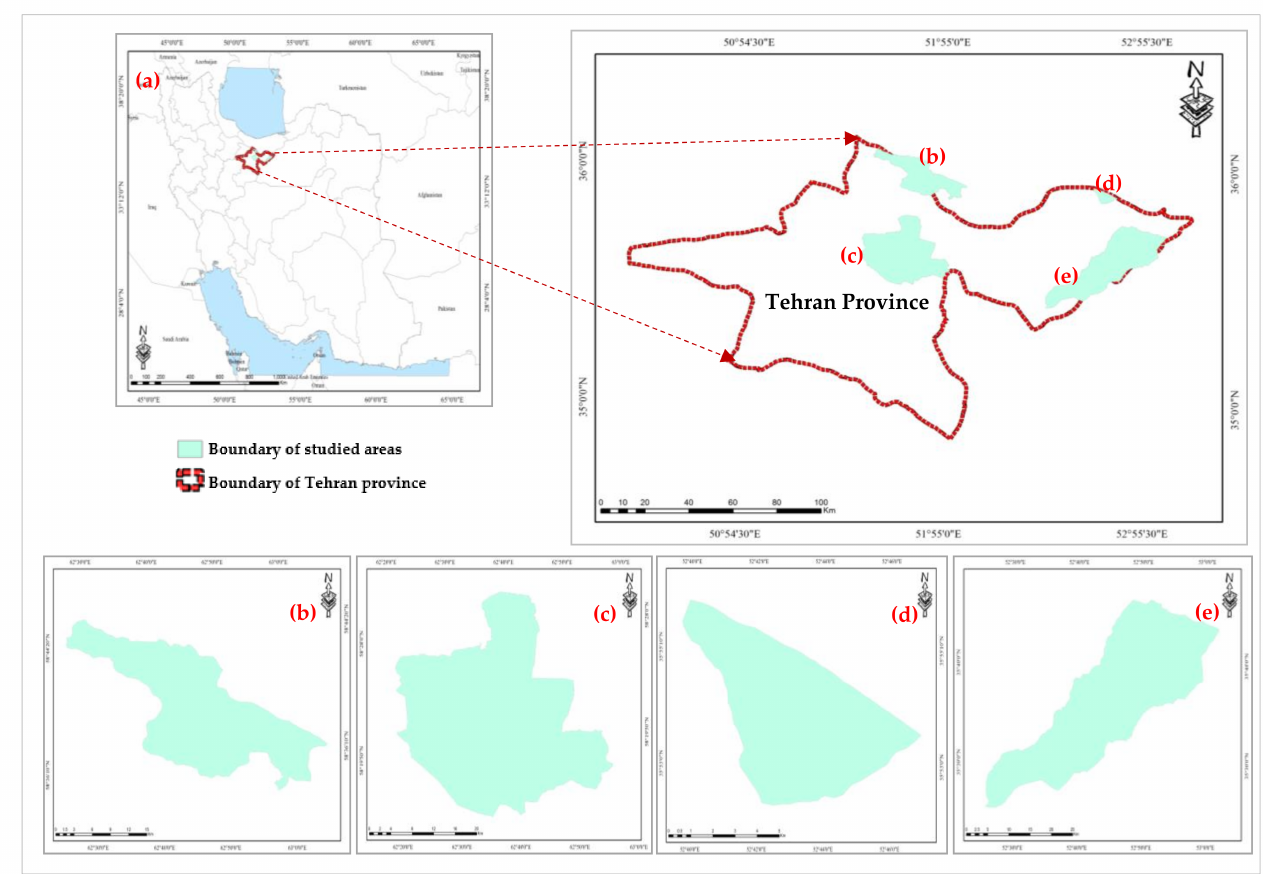
Figure 1. Studied areas: ( a ) Iran and Tehran province, ( b ) Kavdeh Wildlife Refuge, ( c ) Tangeh Vashi National Natural Monument, ( d ) Jajrud Protected Area with Sustainable Use of Natural Resource Areas, ( e ) Lar National